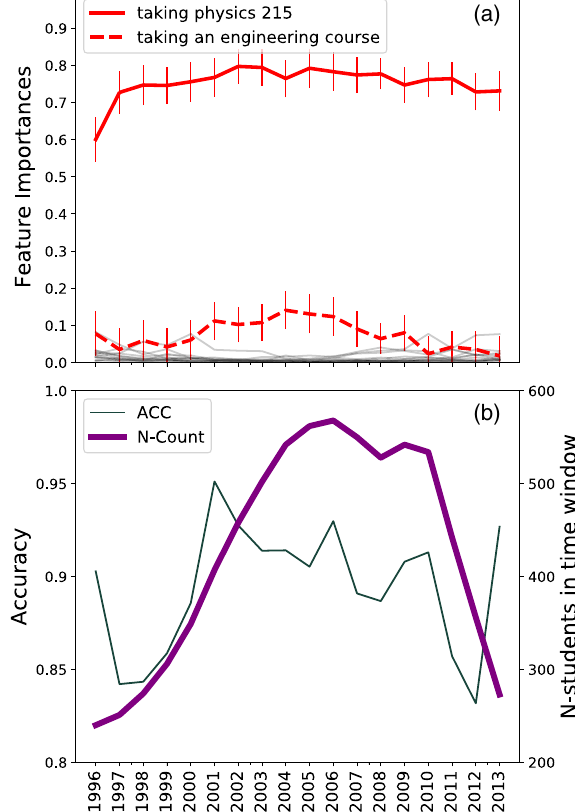
FIG. 5. Sliding time window model. (a) The original grid searched cross validated model parameters were fit to data from sliding time windows ( (cid:2) 3 years) with the window center starting in 1996 and running through 2013. The error bars represent the standard error of the feature importance. (b) The accuracy (ACC) for each of the time windowed models. The dip in the number of students in later years was due to the sampling method; since no students who begin after 2013 are included in the dataset, the total number of students from 2010 begins to